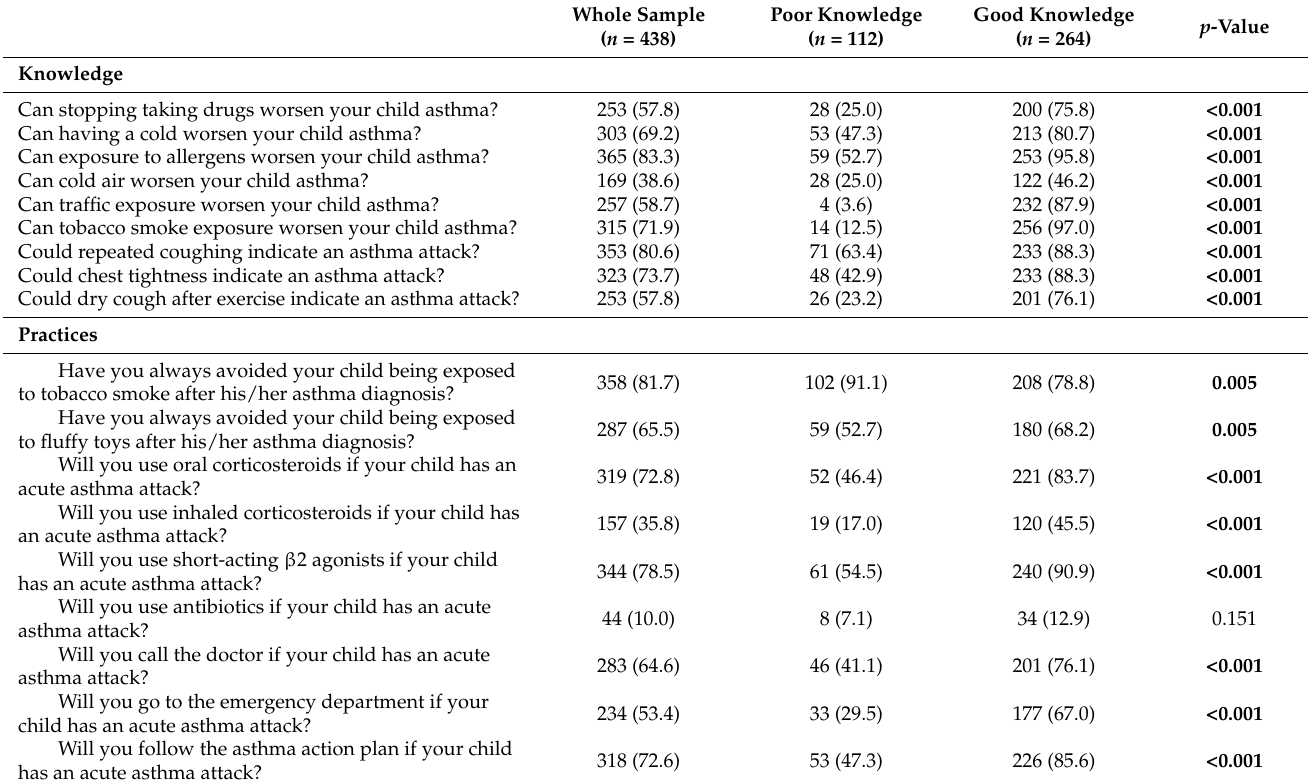
Table 2. Knowledge and practices: distribution of positive answers in the whole sample and by class membership (mothers classified with an assignment probability of at least 0.90). Data are expressed as n (%). Significant p -values are in bold. Whole Sample ( n =